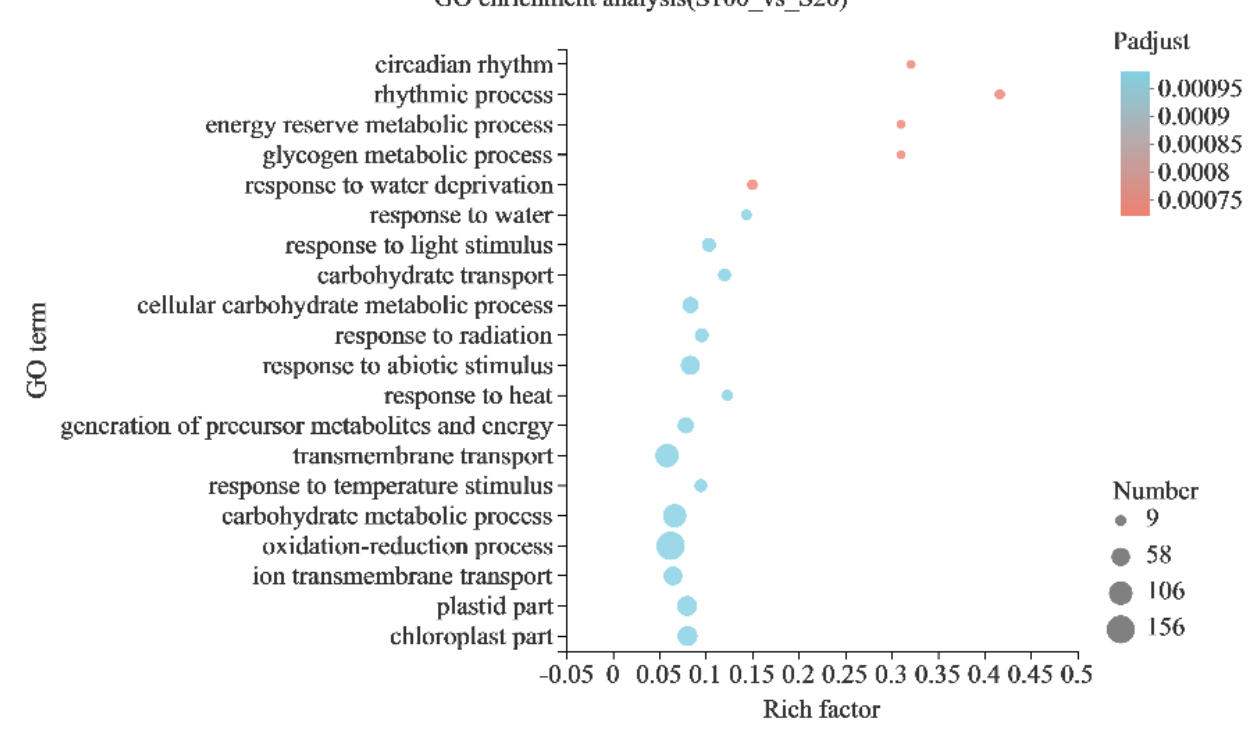
Figure 5. GO enrichment analysis. The vertical axis is the GO entry and the horizontal axis is the ratio of the enriched gene number (sample number) to the annotated gene number (background number) in the entry. The larger the ratio, the higher the enrichment degree. The size of the dot represents the number of genes in the entry; the larger the dot, the more genes there are. The color of the dot shows different P − adjust values; the smaller the P − adjust , the redder the dot. The figure shows the enrichment results of the top 20 entries of P − adjust from small to large.